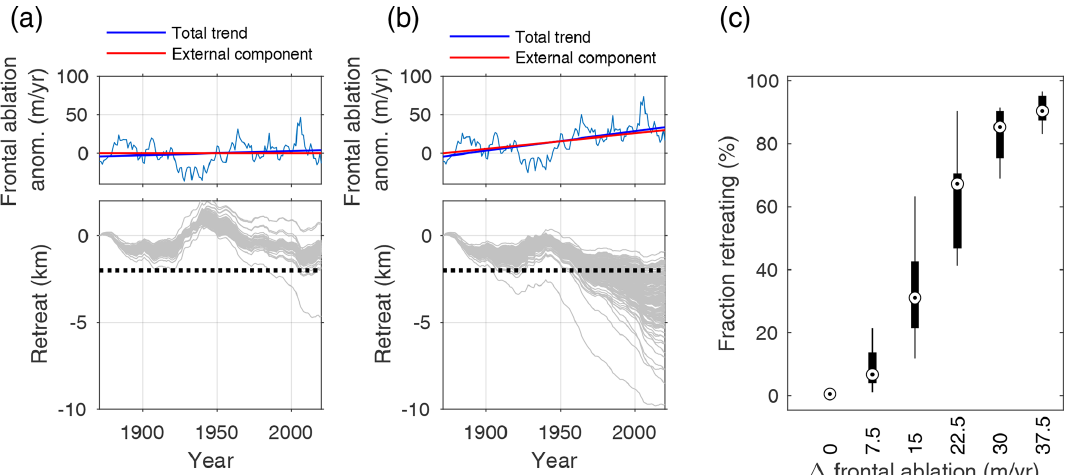
Figure 7. Synthetic attribution experiment for a population of glaciers. (a) Terminus change (relative to year 0) for each glacier, all forced with the same frontal ablation anomalies ( σ FA = 15myr − 1 , top), which have no external forcing trend. The slight overall trend (blue line) is due only to sampling natural variability. Dashed line shows a retreat threshold of 2km. (b) As for (a) except with an external forcing trend in frontal ablation, increasing 30myr − 1 over 150 years. (c) Box plot showing proportion of glaciers in the population exceeding the retreat threshold across six external forcing scenarios. “External frontal ablation” refers to the total linear trend over 150 years. For each level of forcing, 20 simulations of the glacier population are run with different realizations of climate variability (i.e., a small aleatory ensemble), with the distribution of retreats indicated with box-and-whisker